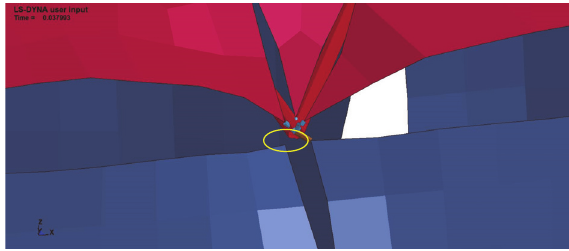
Figure 9: Fracture of connecting component.